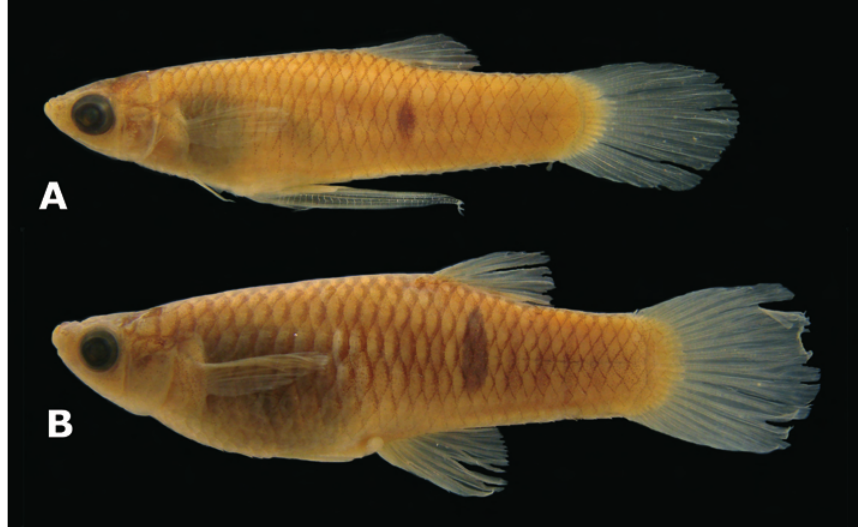
Fig. 38. Phalloceros lucenorum . (A) Holotype, male, 26.1 mm SL, MCP 30404, Juquiá, creek on road BR 116, near Juquiá (affluent to rio Juquiá), São Paulo, Brazil; (B) paratype, female, MCP 12197, 33.5 mm SL, collected with the